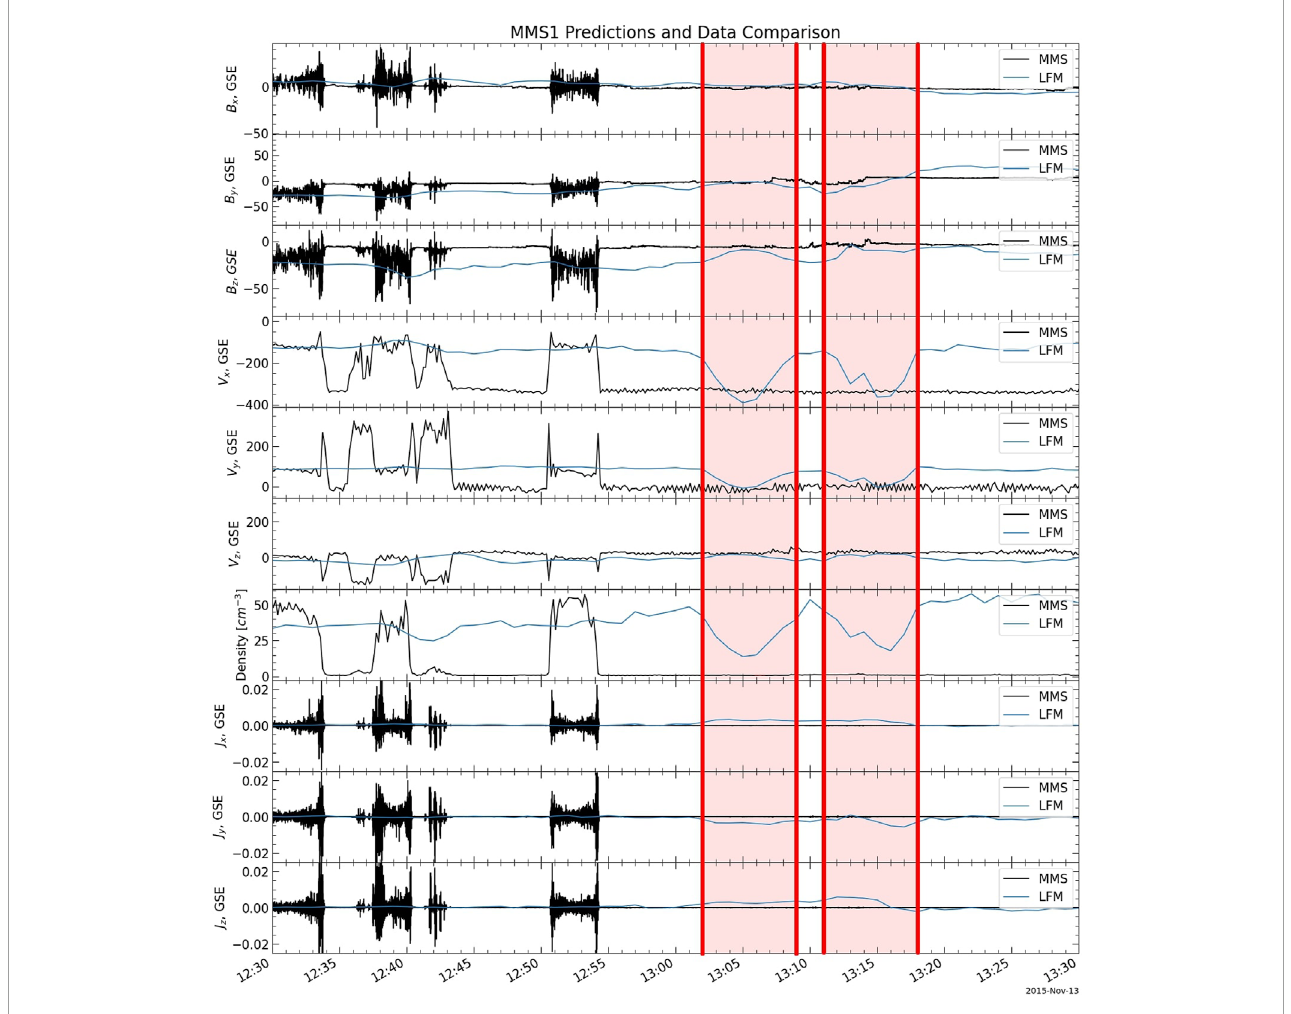
FIGURE 7 MMS1 data (black) and LFM output along the MMS1 track (blue) for the hour around the crossing time on 2015 November 13. Although the modeled satellite did not encounter the bow shock exactly at 12:54 UT or during the earlier crossings shown, the modeled bow shock was near the MMS position, as shown by several predicted encounters with the boundary (marked in red) around 13:05 and 13:15 UT. The periods spent out in the solar wind are shaded red. From the top, the plotted quantities are the magnetic field components B x , B y , B z , proton bulk velocity components V x , V y , V z , the proton number density, and the components of the current J x , J y , and J z . Vector quantities are in GSE coordinates. The current from LFM is in μ A (see explanation in